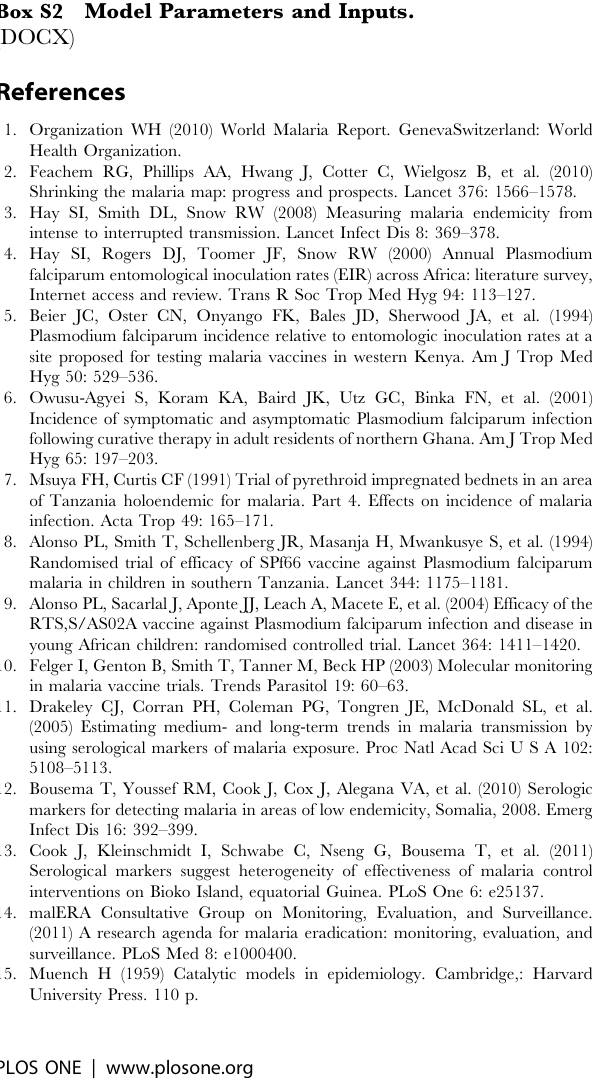
Figure S1 Compartment models for effects of treatment on prevalence. Model A corresponds to the model in the main text, which considers all parasites in an infected host as equivalent; Model B is an infinite server queuing model, where the effect of treatment is to remove only one infection at a time. The value of n is the number of concurrent co-infections (multiplicity of infection): only the first three infected categories are shown. Model C is a variant of the infinite server model, in which treatment removes all infections. (TIF) Figure S2 Comparison of prevalence values predicted by different models. The black dots each correspond to the means of 1000 simulations of the model illustrated in Figure S1C . The red lines to prevalence predicted by model S1A ; the blue lines to that predicted by model S1B , and the black lines to the approximation in equation A11. In all cases a clearance rate of 0.005 per day was assumed. (TIF) File S1 Models treating super-infections as indepen- dent of each